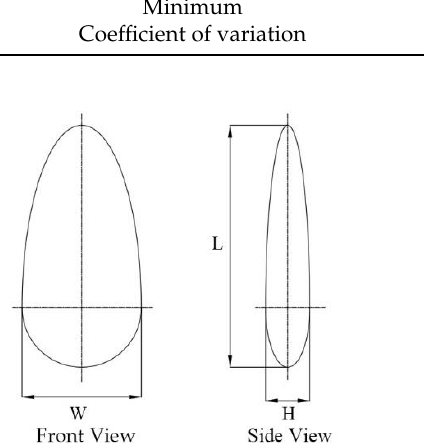
Figure 3. Schematic diagram of the triaxial dimensional structure of the seed. Table 1. Triaxial size of sunflower seeds.